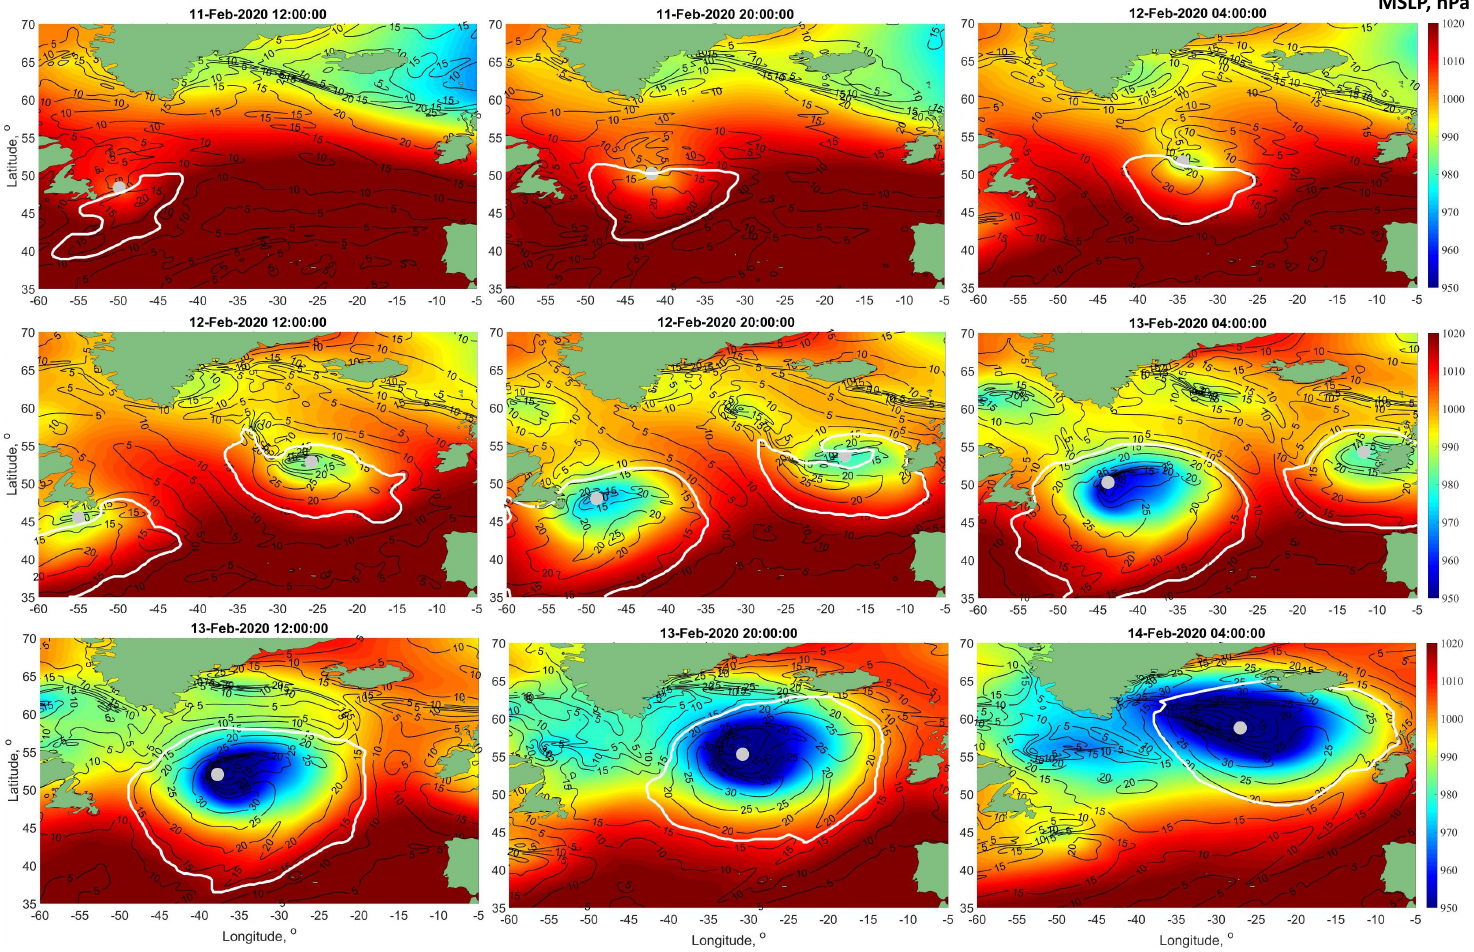
Figure 1. Mean sea level pressure, MSLP, maps with wind speed contours in ms − 1 . White contours are the storm area of ETCs with the gray circle as their